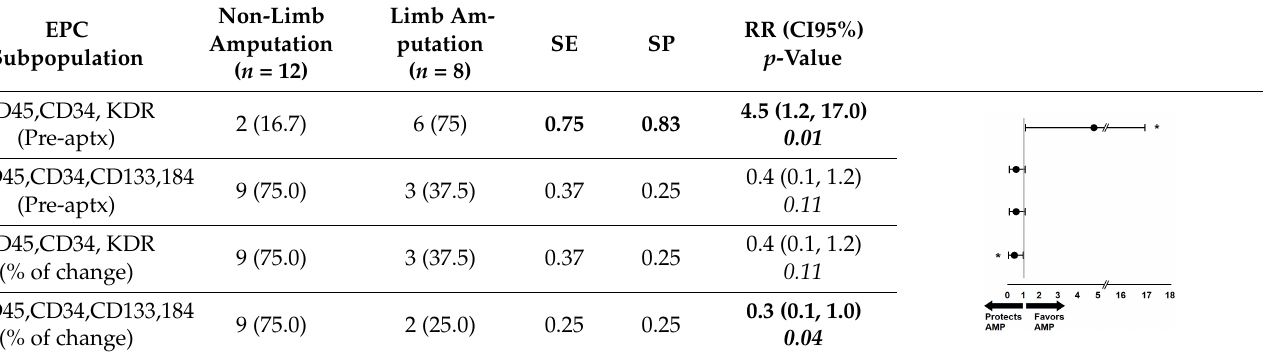
Table 3. Associated risk.